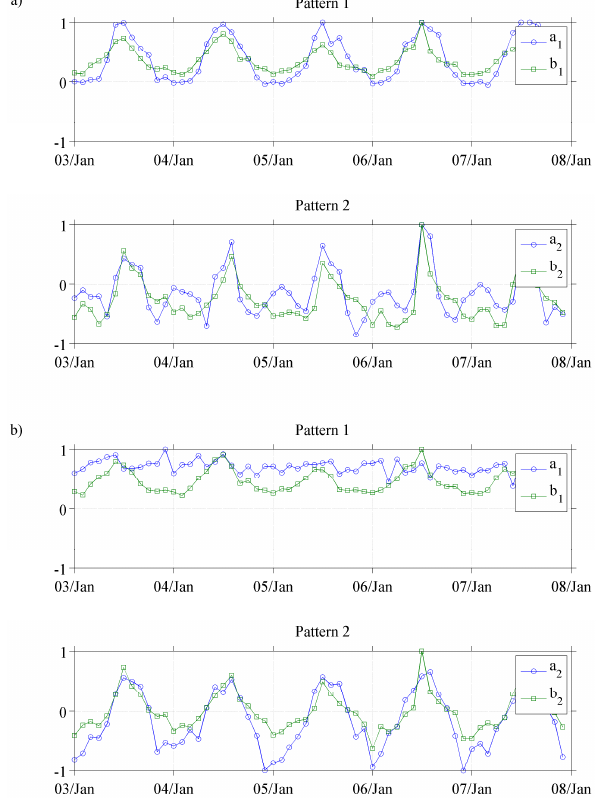
Fig. 10. The time series of the expansion coefficients between the pair of patterns: (a) Spatial patterns of TRMM precipitation and Figure 10: The time series of the expansion coefficients between the pair of patterns: a) MODIS AOD, (b) Spatial patterns of MODIS COD and MODIS Spatial patterns of TRMM precipitation and MODIS AOD, b) Spatial patterns of MODIS COD and MODIS AOD.